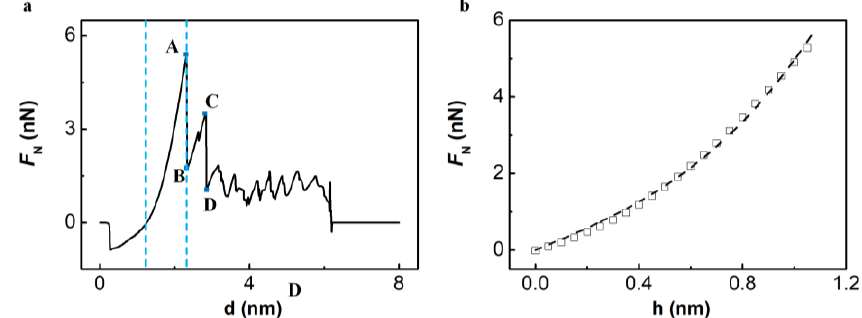
Figure 2. ( a ) The force-displacement (F N (d)) curve for the indentation process of the freestanding BP monolayer; ( b ) The force displacement curve at elastic stage (corresponding to curve between the two blue dashed line in Figure 2a), and the dashed line is a nonlinear fit of Formula (1).